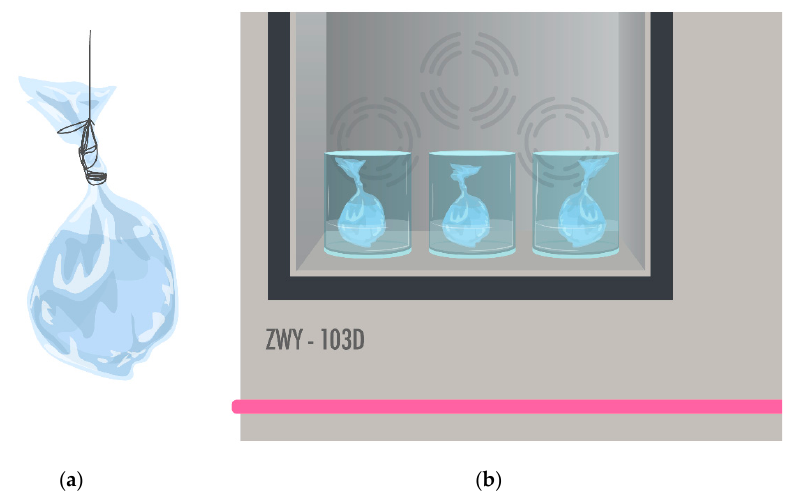
Figure 1. ( a ) Dialysis tubing with MA/EA NP suspension to evaluate glibenclamide release; ( b ) Shaker-incubator with dialysis tubing in PBS pH 7.4 solution.